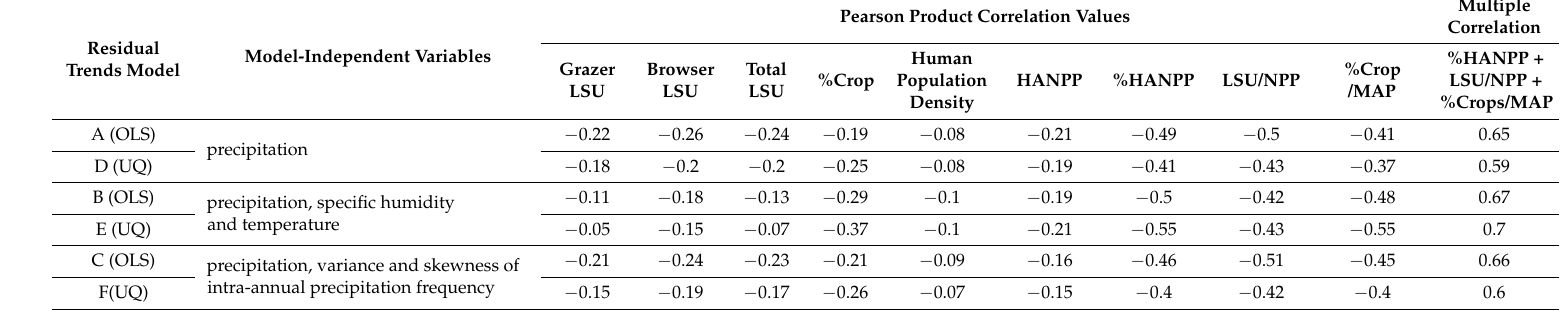
Table 3. Correlation values (r) between RESTREND, population, and land use. The multi-correlation value was estimated from the relation of RESTREND values